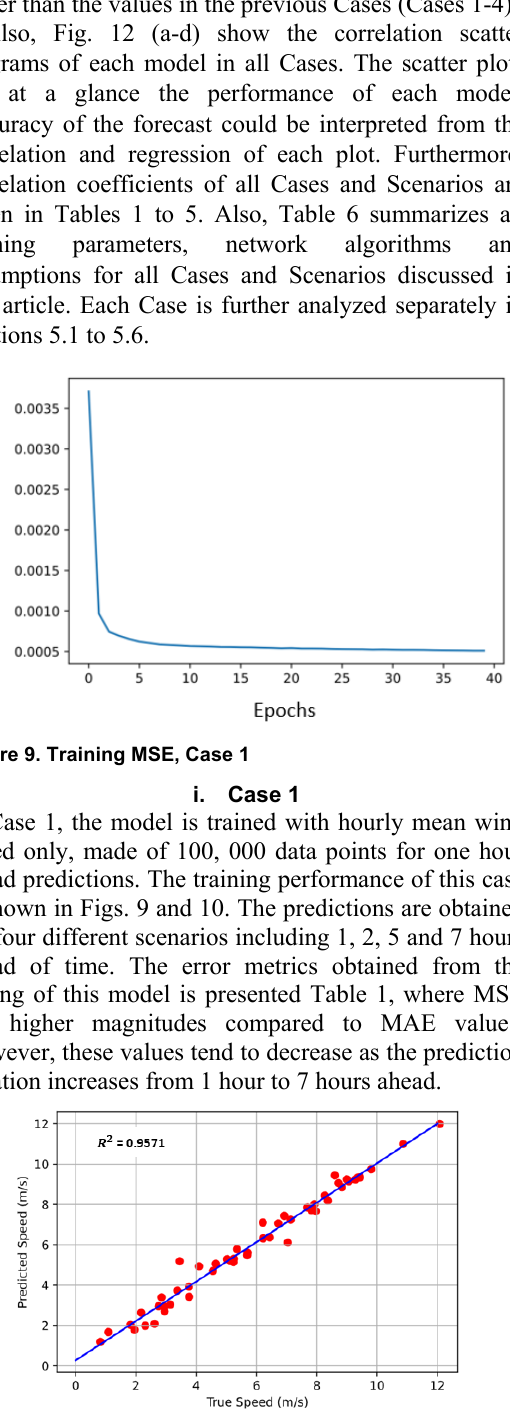
Figure 10. Correlation plots between measured and predicted wind speeds, Case 1